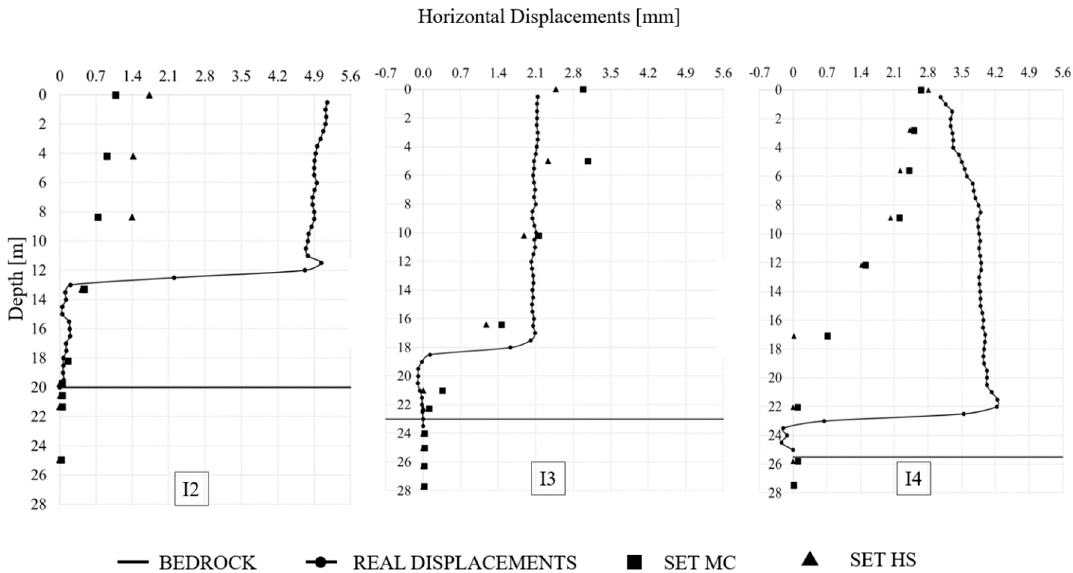
Figure 12. Groundwater level rise occurred from January 2018 to March 2018: comparison between real and simulated horizontal displacements at inclinometer I2, I3 and I4.